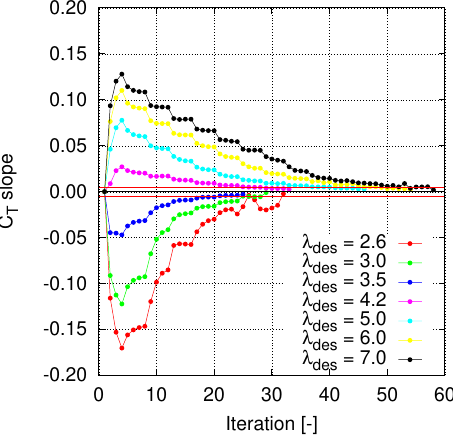
slope for λ des T